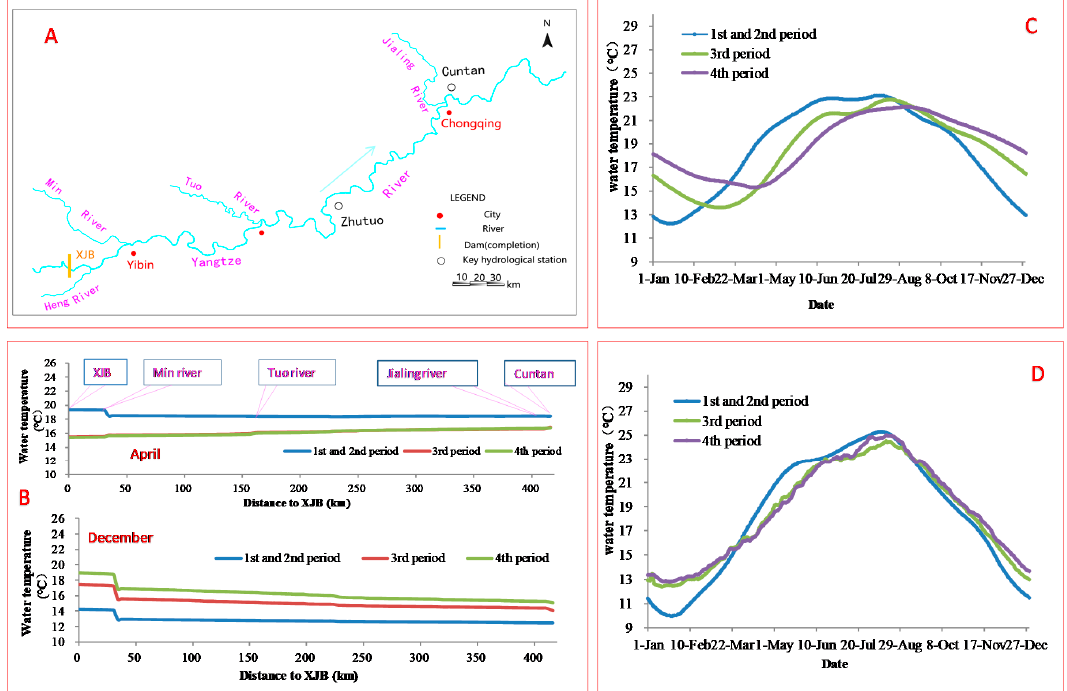
Figure 6. The simulated results of water temperature between XJB and Cuntan over the four periods. ( A ): The calculation domain. ( B ): The water temperature along the river between Xiangjiaba and Cuntan in April and December. ( C ): Daily water temperatures at XJB. The water temperatures in the 1st and 2nd periods are the average daily water temperatures measured from 1984 to 2012; the water temperatures in the 3rd and 4th periods are the simulated data. ( D ): Daily water temperatures at Cuntan; the water temperatures are simulated data. In the 1st and 2nd periods, XJB had not yet been completed, and there was no dam upstream of Cuntan; in the 3rd period, XJB and XLD had been completed. In the 4th period, XJB, XLD, BHT, and WDD had been completed.